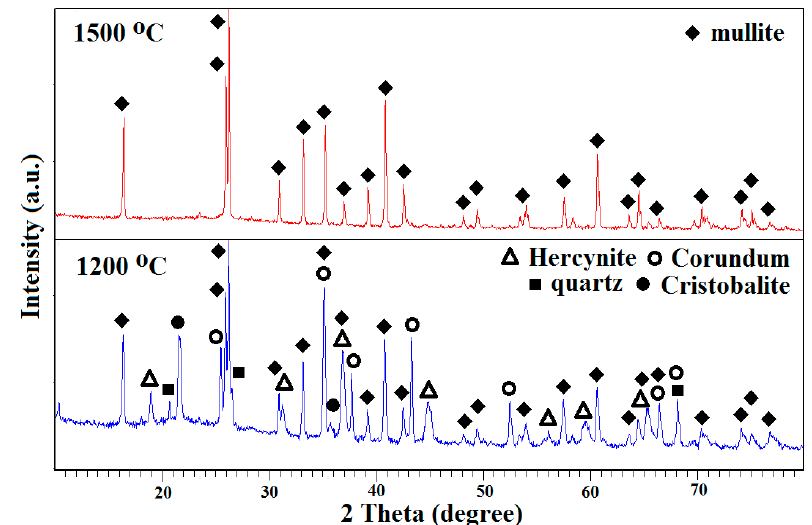
Figure 4. XRD patterns show the crystalline phase identification of two mullite precursor powders fired at (top) 1500 °C and (bottom) 1200 °C.